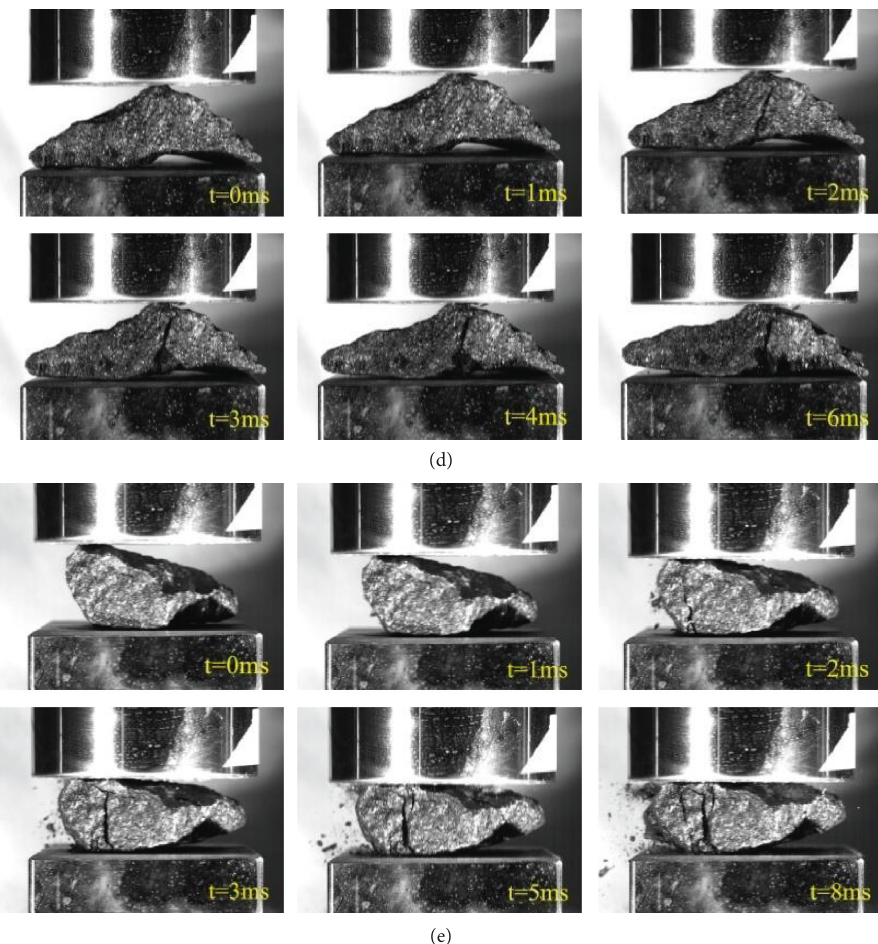
Figure 10: Photographs of impact breakage process recorded by high-speed camera. (a) Sample code is SQ89, mass is 259g, sphericity is 0.64, specific breakage energy is 169J/kg, and fragment number is three. (b) Sample code is S17, mass is 265g, sphericity is 0.66, specific breakage energy is 248.7J/kg, and fragment number is three. (c) Sample code is SQ87, mass is 256g, sphericity is 0.74, specific breakage energy is 305.1J/ kg, and fragment number is three. (d) Sample code is S16, mass is 232g, sphericity is 0.579, specific breakage energy is 128.4J/kg, and fragment number is four. (e) Sample code is SQ90, mass is 260g, sphericity is 0.74, specific breakage energy is 223.7J/kg, and fragment number is